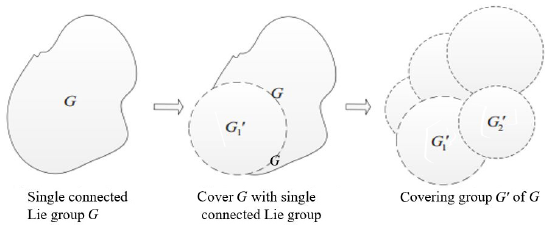
Fig. 7 Transformation from simply connected Lie group G to its covering group G 000 , here G 000 is the covering group of Lie group G